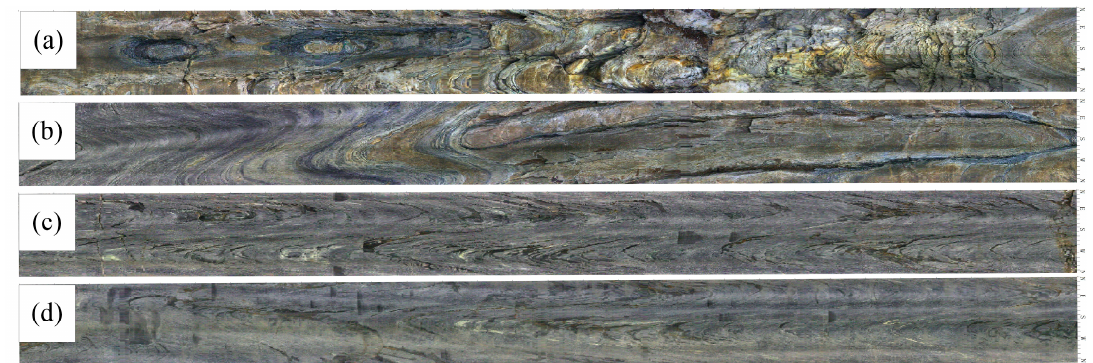
Figure 8. The results of core drilling of the verification hole DJ1-1: ( a ) The core specimen image of DJ1- 1 from depths of 2.3–3.9 m; ( b ) the core specimen image of DJ1-1 from depths of 10.4–11.7 m; ( c ) the core specimen image of DJ1-1 from depths of 13.6–15.5 m; and ( d ) the core specimen image of DJ1-1 from depths of 21.9–23.9 m.